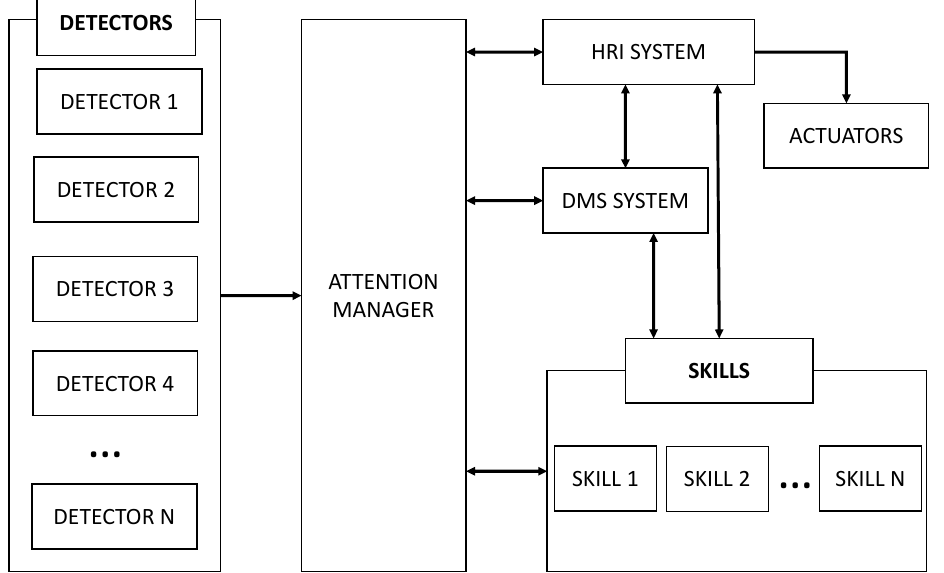
Figure 2. A general overview of the main software components of the Mini architecture and the connections between them. This work added the attention manager block, which communicated with the HRI and DMS systems and the robot’s